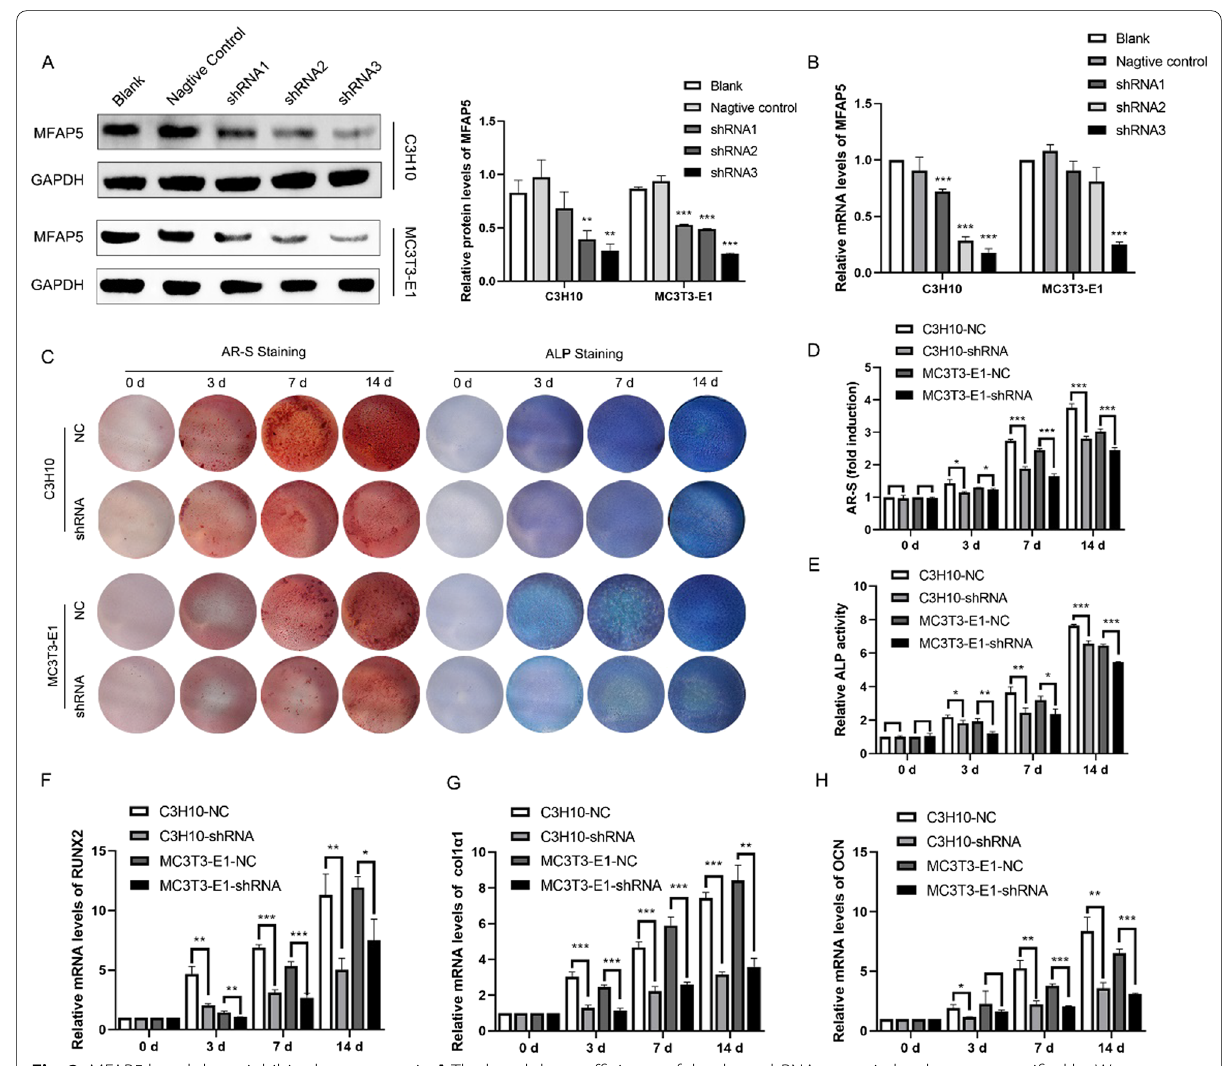
Fig. 2 MFAP5 knockdown inhibited osteogenesis. A The knockdown efficiency of the three shRNAs; protein levels were quantified by Western blotting. B The mRNA level of MFAP5 in C3H10 and MC3T3-E1 cells, as revealed by qRT-PCR. C AR-S and ALP staining showed that MFAP5 knockdown inhibited the osteogenic capacity of C3H10 and MC3T3-E1 cells. D and E Quantitative analyses of ALP expression and AR-S staining. F – H The mRNA levels of classical biomarkers of osteogenic differentiation (Runx2, Col1α1, and OCN) in the shRNA and NC groups. Values are expressed as means standard deviations (*P < 0.05, **P < 0.01, ***P < ±